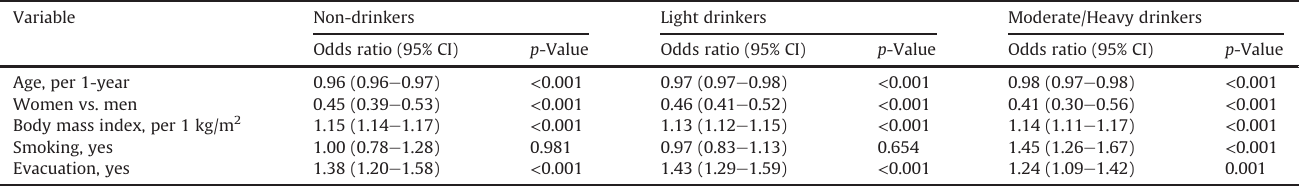
CI, con fi dence interval.